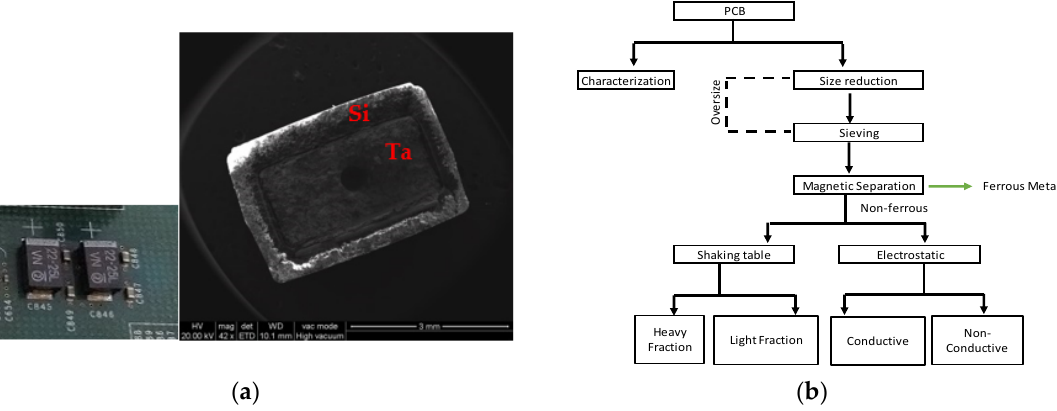
Figure 2. Tantalum capacitor in the PCB and also analysed with SEM ( a ); Process flowsheet applied in this study ( b ).